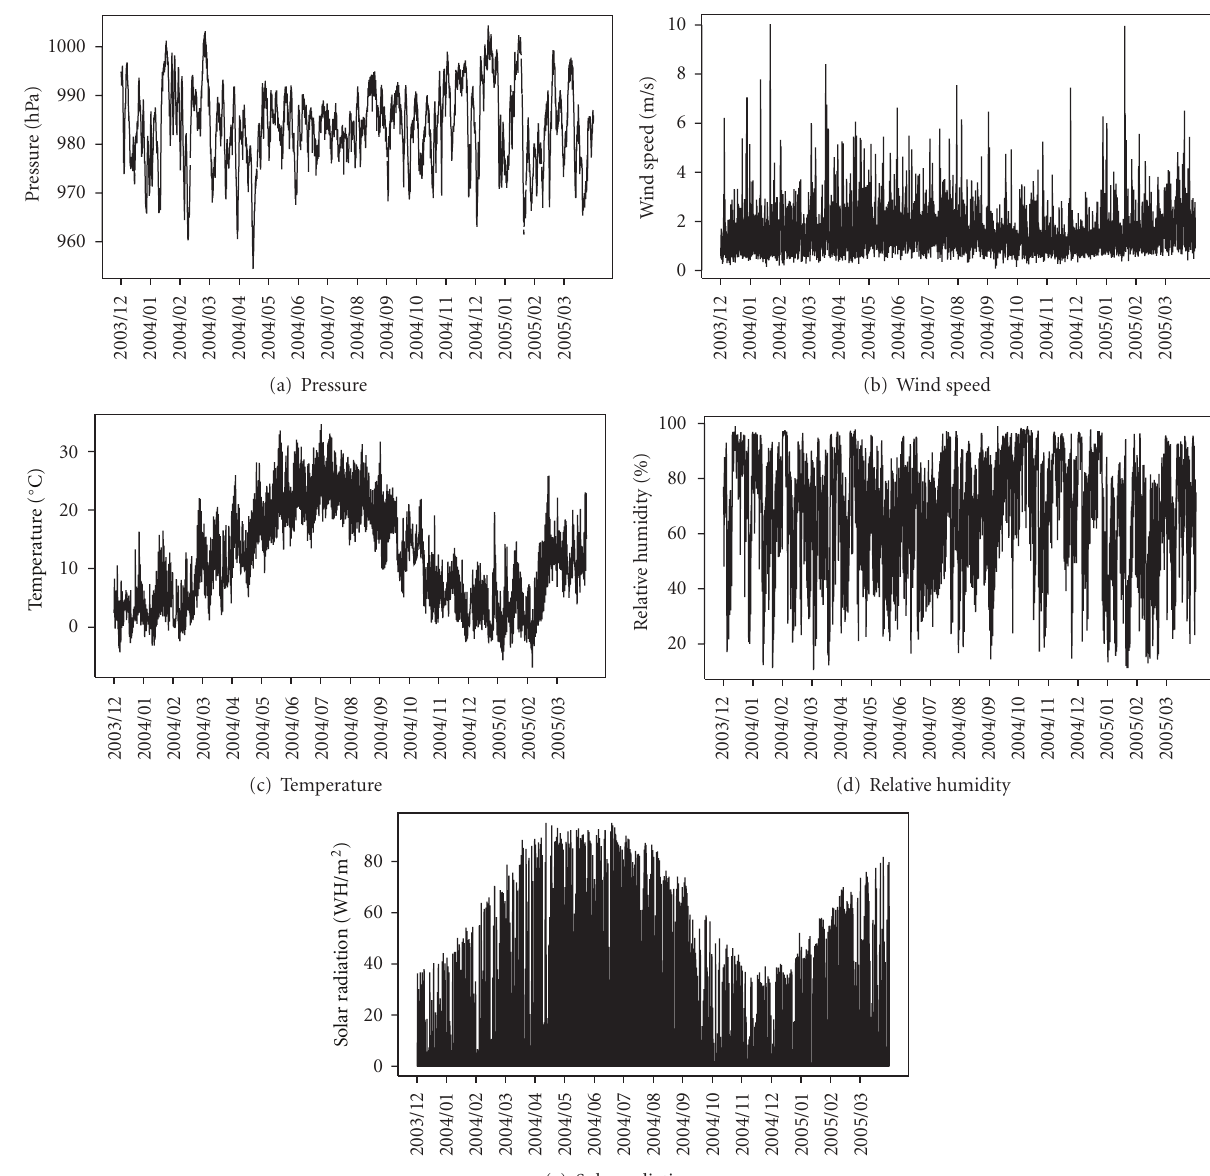
Figure 5: Time series of the averaged meteorological